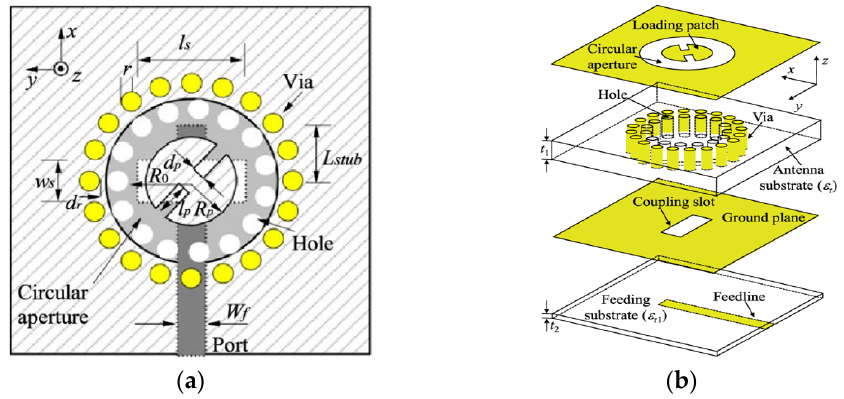
Figure 18. Geometry of CP substrate-integrated CDRA: ( a ) top view; ( b ) perspective view [77].